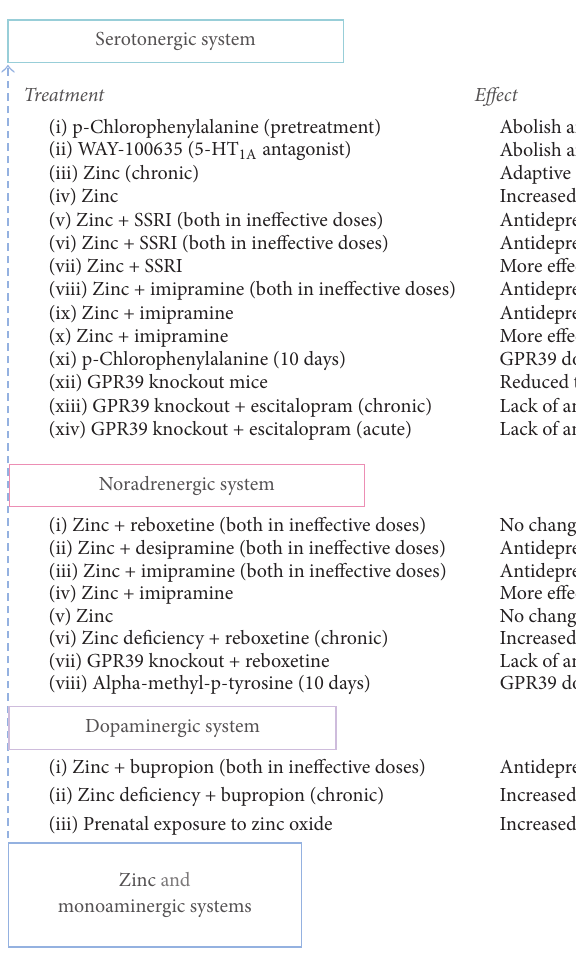
Figure 1: The summary of the findings related to interactions between zinc and monoaminergic systems and neural plasticity pathways. SSRIs (fluoxetine, citalopram) reduced depressive